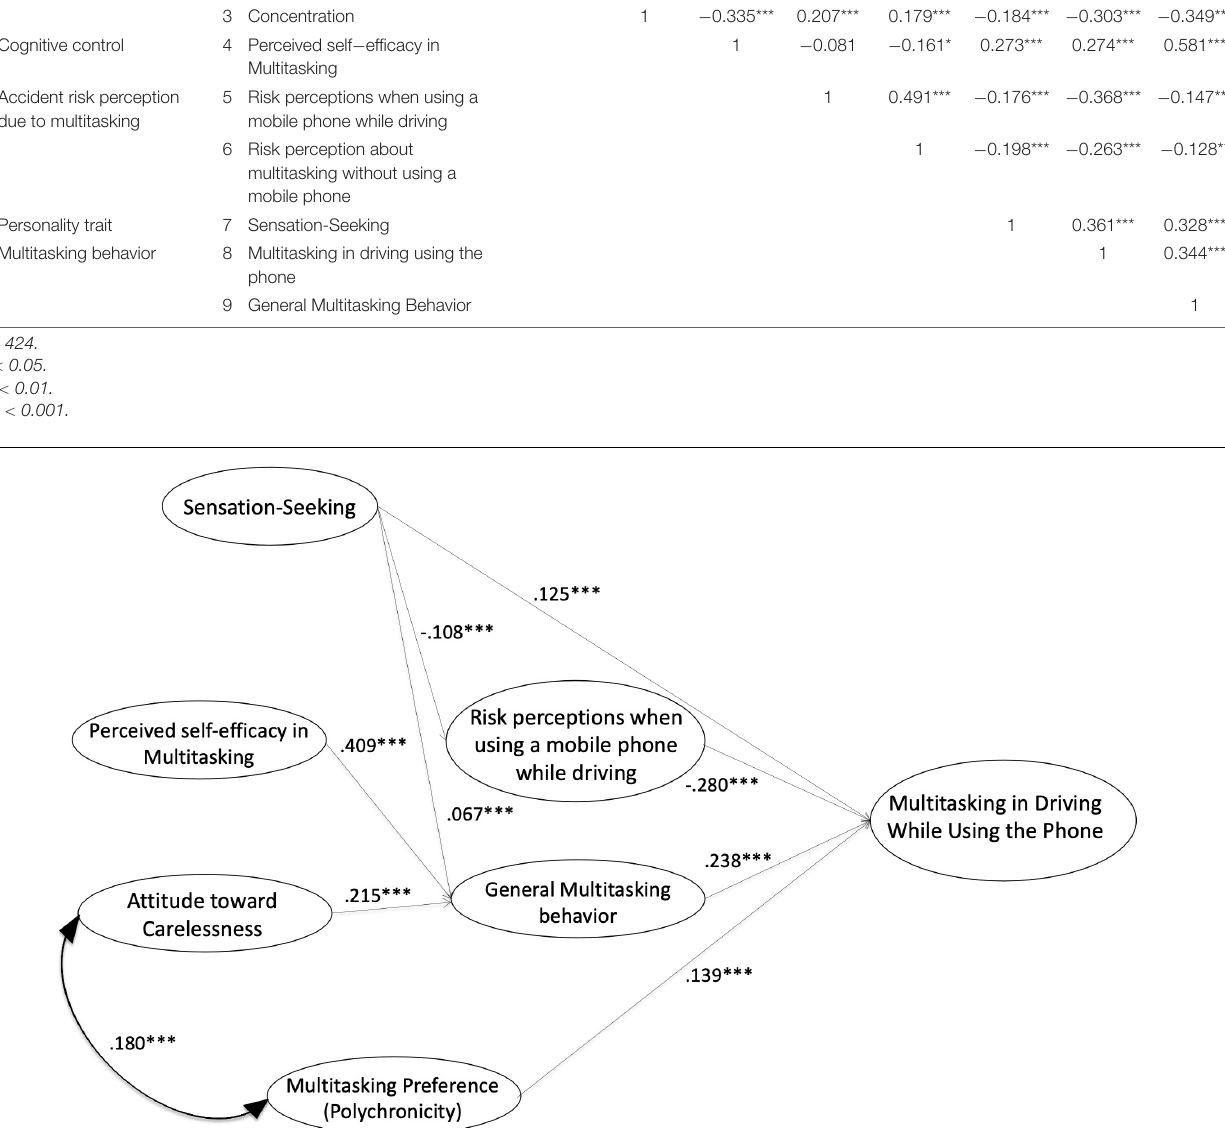
perception about multitasking without using a mobile phone were excluded in the first significant model. Secondly, a very large Modification Index was used indicated a relevant relationship between the independent variables and risky behaviors.